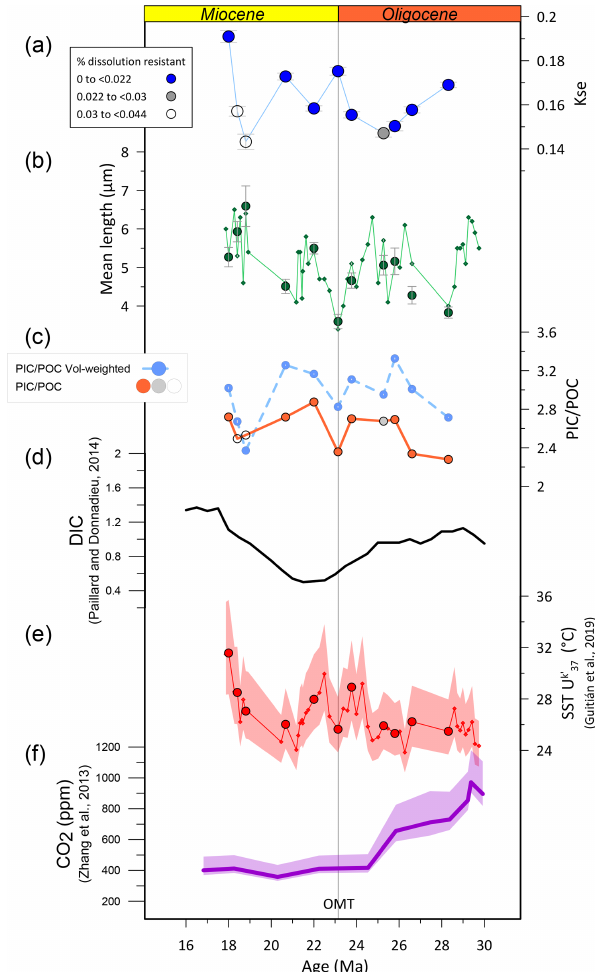
Figure 7. Temporal trend in Reticulofenestra median coccolith k se vs. other morphological and environmental parameters. (a) Me- dian Reticulofenestra k se . Symbols are coded to indicate the rela- tive abundance of dissolution-resistant nannofossils, with filled blue symbols denoting the populations which may be least affected by dissolution. (b) Length of samples examined in this study (median, large green symbol) and mean size in a higher resolution previously published (Guitián et al., 2020) in small symbols. (c) Estimated PIC / POC ratio (particulate inorganic carbon to particulate organic carbon) for the assumptions described in the text. The darker sym- bol indicates the calculation for the median thickness and length, with filled orange symbols for the higher relative abundance of dissolution-resistant nannofossils. The light-blue symbol and line denote the estimated population PIC / POC ratio, which is weighted by the size distribution as discussed in Guitián et al. (2020). (d) Es- timated ocean dissolved inorganic carbon (DIC) concentration from Paillard and Donnadieu (2014). (e) Sea surface temperature (SST) estimated from the alkenone unsaturation index, from Guitián et al. (2019). (f) Estimated atmospheric CO 2 from Zhang et al.